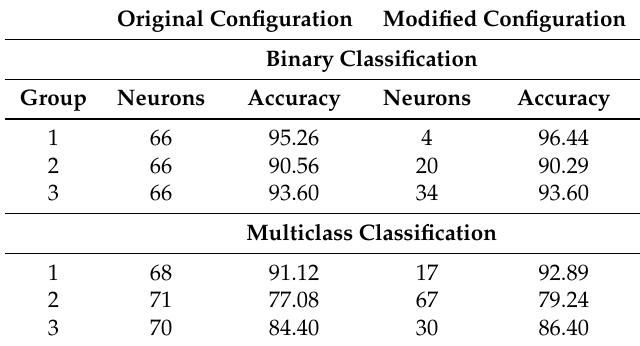
Table 6. Summary of best classification accuracy versus hidden neuron